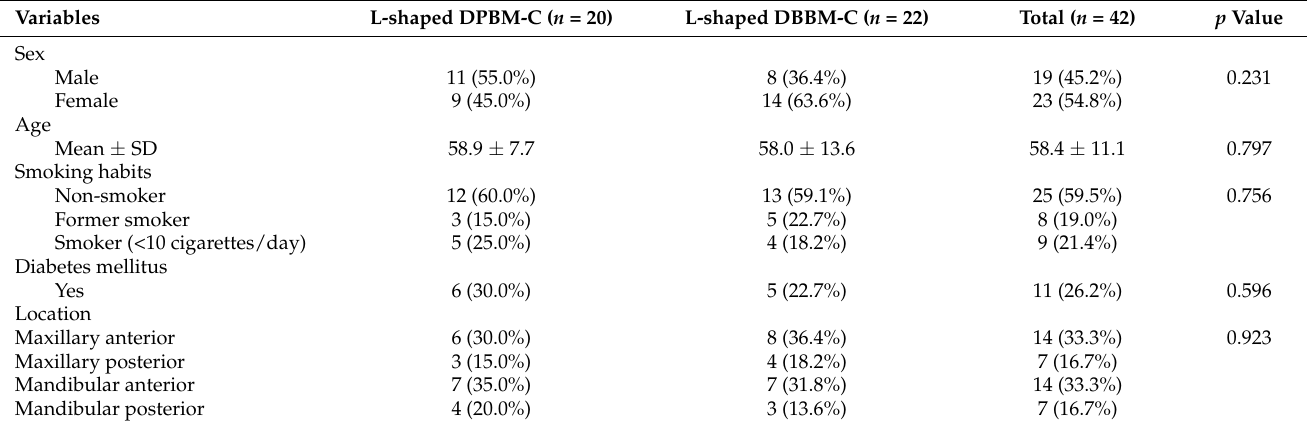
Table 1. Baseline characteristics of the enrolled patients in the L-shaped DPBM-C and DBBM-C groups.